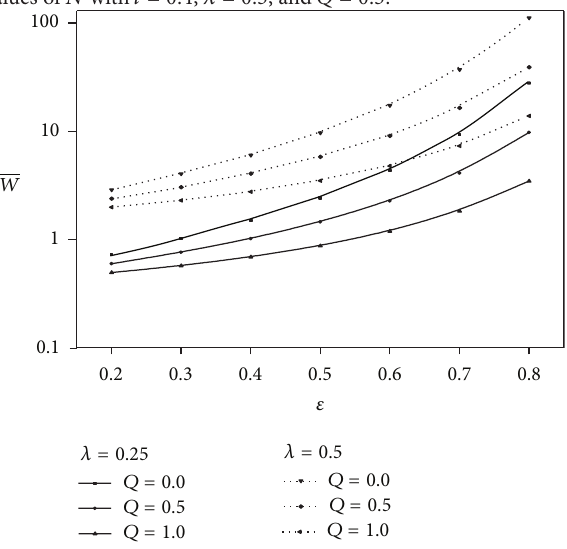
Figure 3: Variation of nondimensional 𝑝 with 𝜃 for different values of 𝑁 with 𝑙 = 0.4 , 𝑄 = 0.5 , 𝜀 = 0.2 , and 𝜆 = 0.5 .